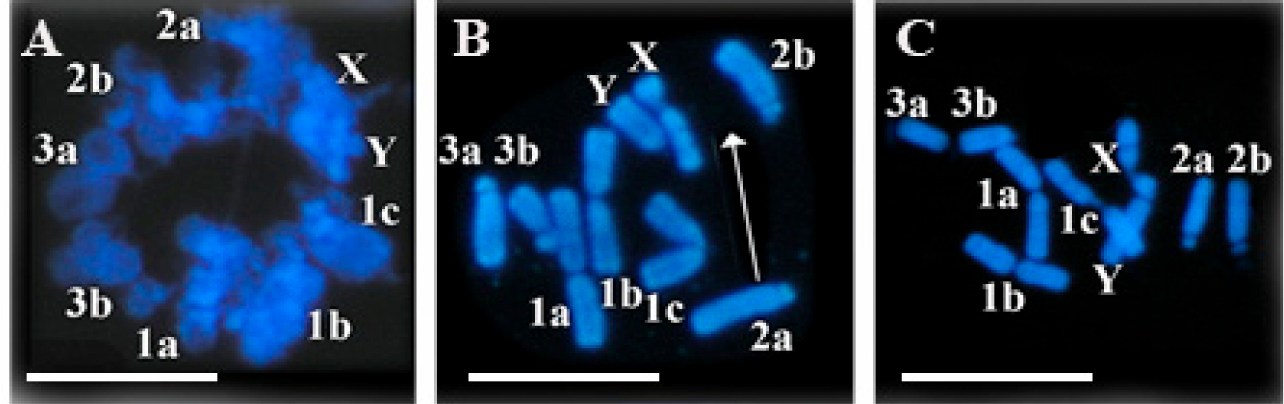
Figure 9. Linear attachment of Indian muntjac chromosomes. Diploid state is indicated for chromo- somes 2 and 3 with letters (2a, 2b; 3a, 3b), chromosome 1 is triploid (1a, 1b, 1c), sex chromosomes are X and Y. ( A ) Interphase chromosomes. ( B ) Metaphase chromosomes with chromosome #2a abandoning its place during isolation (indicated by the white arrow), ( C ) properly ordered chromosomes and the sequence of metaphase chromosomes: 3,3, 1,1,1, y,x, 2,2. Scale bar 20 µ m